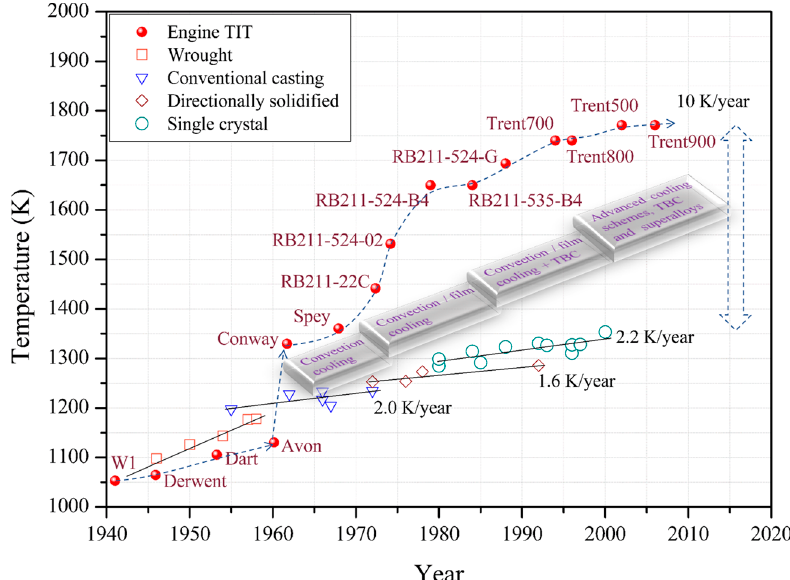
Figure 2. Evolution of the TIT of Rolls-Royce’s civil aero-engines, the maximum allowable temper- ature of nickel-base superalloys, and the thermal protection techniques. Data collected from [9–11].